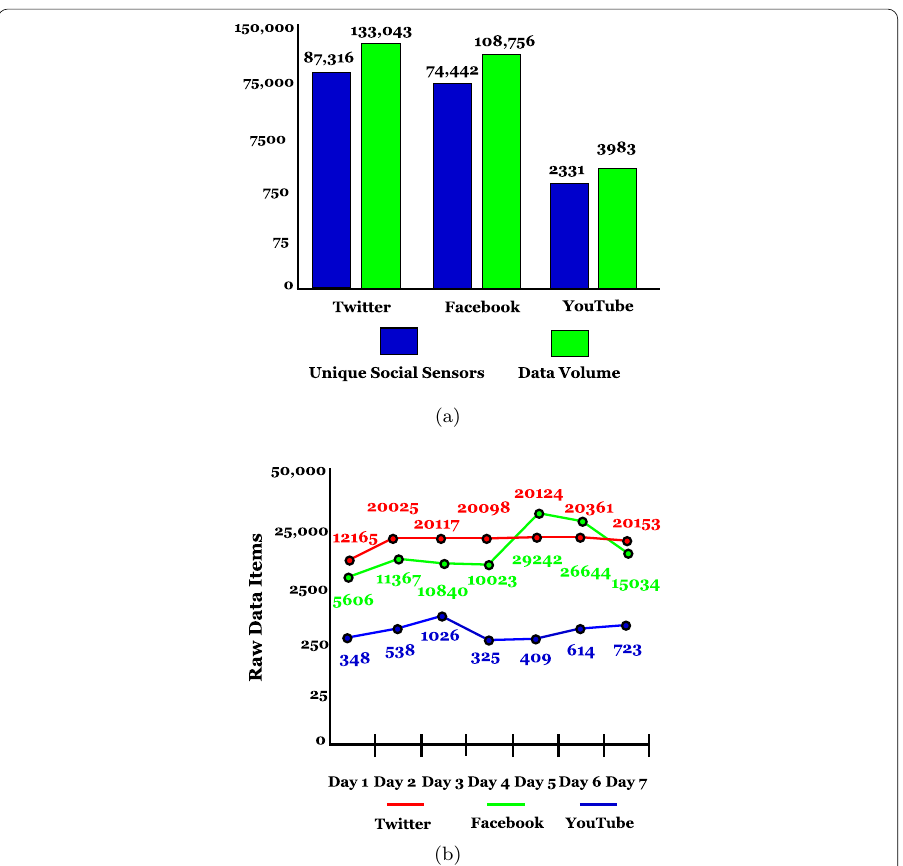
Fig. 4 a Richness: social sensors to data volume comparison b Freshness: data